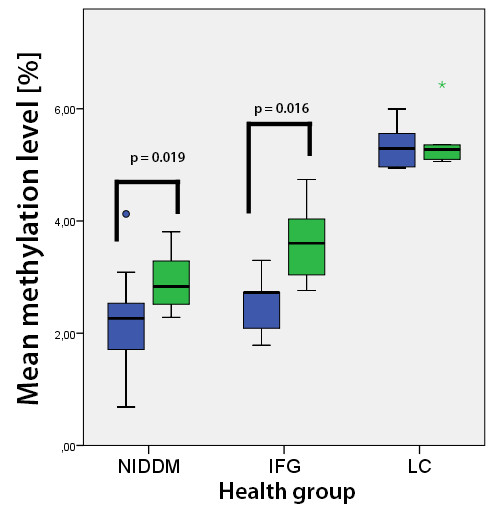
MLH1 region 1 meanDNA methylation levels. Detail of MLH1 region 1. Mean DNA methylation levels over seven CpGs in the intervention groups, non-insulin-dependent diabetes mellitus type 2 (NIDDM2) and impaired fasting glucose (IFG), and the lean control group (LC). P-values are based on the paired t-test.